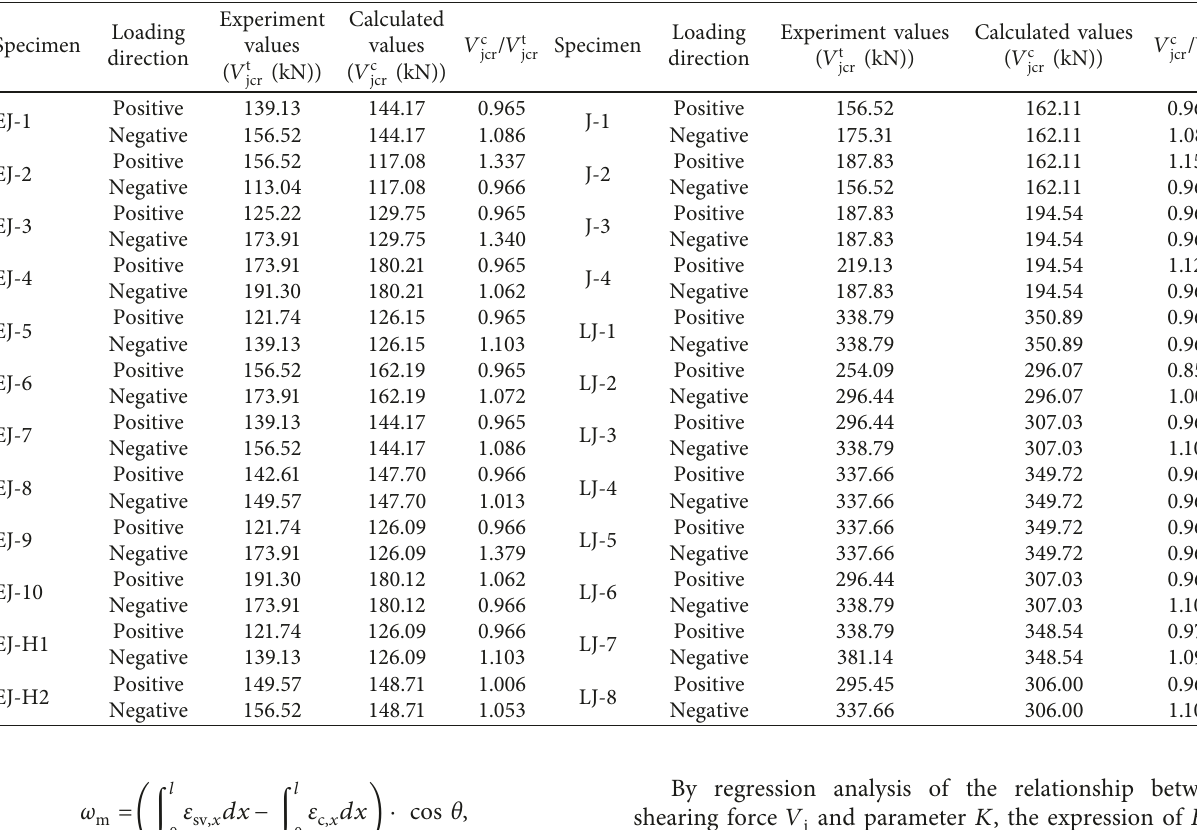
Table 4: Comparison of HPFRC joint cracking strength between calculated values and experimental values.